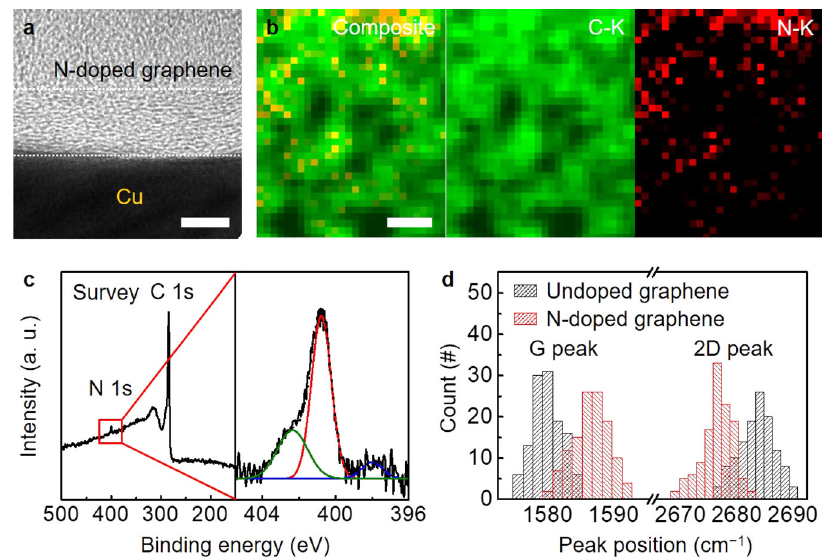
Fig. 2 Characteristics of the N-doped graphene on Cu interconnects. a HRTEM image, b EELS mapping images, and c XPS spectra of N- doped graphene synthesized on the Cu interconnect using pyridine by APCVD at 400 °C. d G and 2D peak position distributions of undoped and N-doped graphene estimated from Raman mapping images of Supplementary Fig. 8. Scale bars, 5 nm in a and b